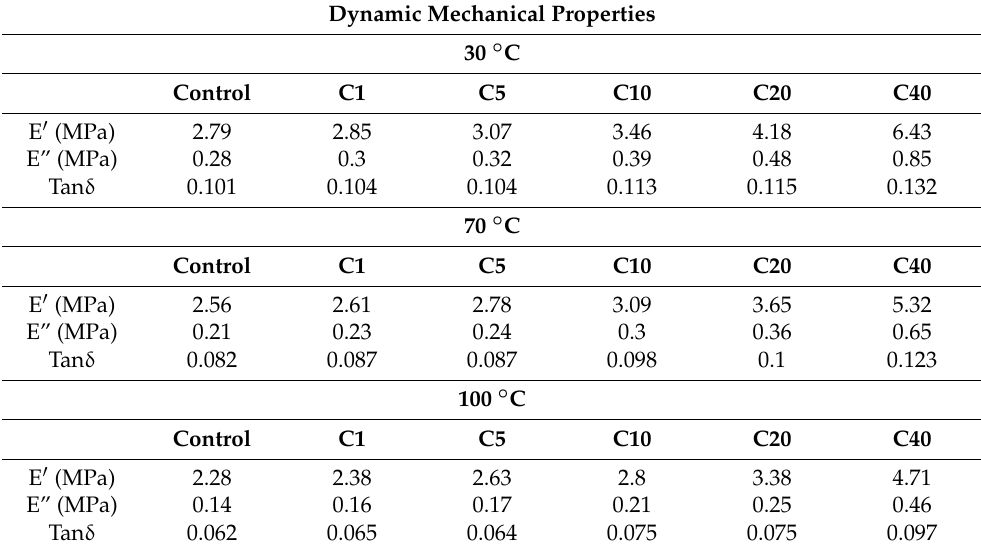
Table 4. Dynamic-mechanical properties of the compounds. Dynamic Mechanical